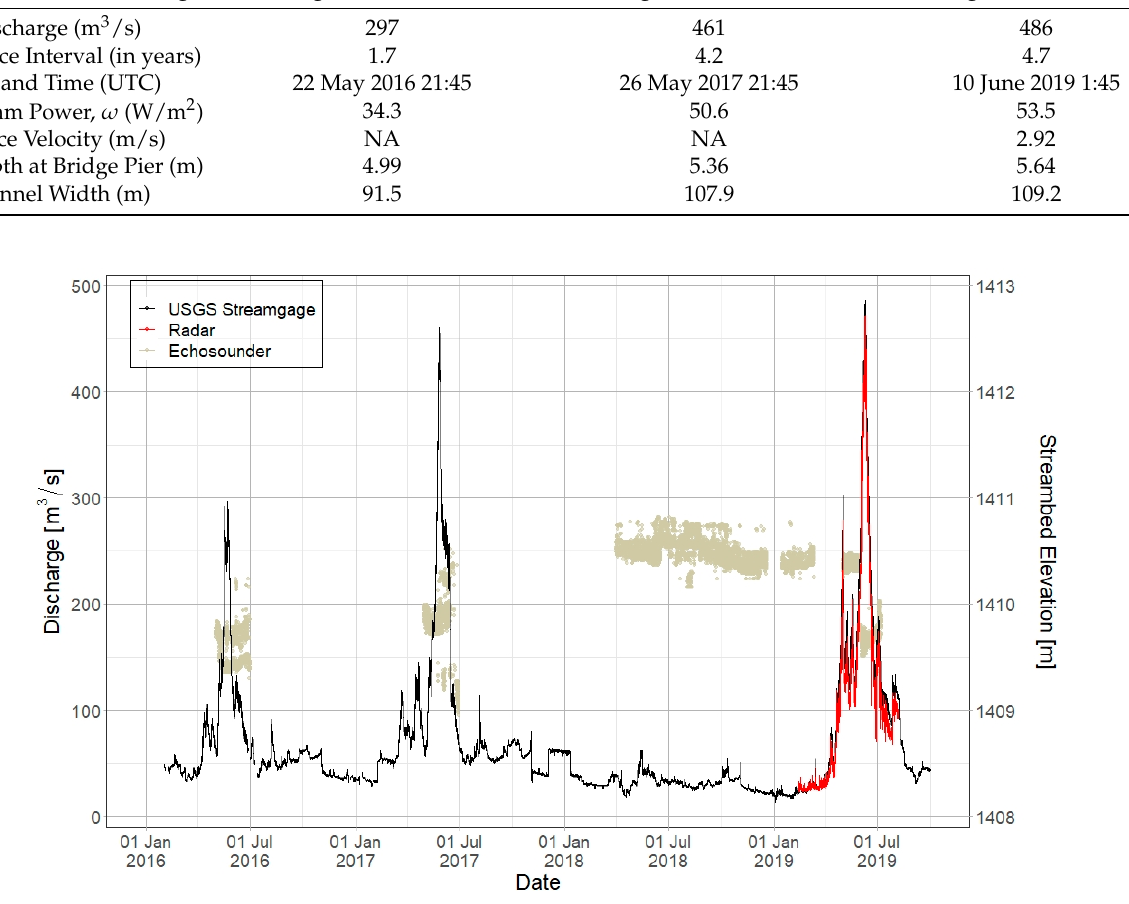
Figure 3. Time series of discharge and streambed elevation datasets collected at the study site. The black line represents discharge estimates generated from conventional methods at the USGS stream- gage (09125000), the red line denotes discharge estimates generated from the PC method based on measurements from the radar, and the tan circles denote streambed elevation data collected from the single-beam echosounder. Discharge estimates are in cubic meters per second and correspond with the primary ( left-hand ) y -axis, whereas streambed elevation data are in meters above NAVD 88 and correspond with the secondary ( right-hand ) y -axis. The position of the y -axis was determined by first collecting a series of vertical veloc- ity profiles along a cross-section immediately upstream from the bridge using an ADCP and a stationary moving bed test (SMBT). Velocity data from the SMBT was processed in WinRiver II software to determine the position of the y -axis and thus the location where the radar was installed. An R-script was then used to automatically extract parameters required for the PC method from the vertical velocity profile. Radar-based surface velocity and stage data were recorded every 15 min and transmitted every hour. Radar-based ve- locity, stage, and siting data were published by [61]. 2.2.3. Conventional In-Stream Instrumentation and Measurements Used for Computations and Validation of Noncontact